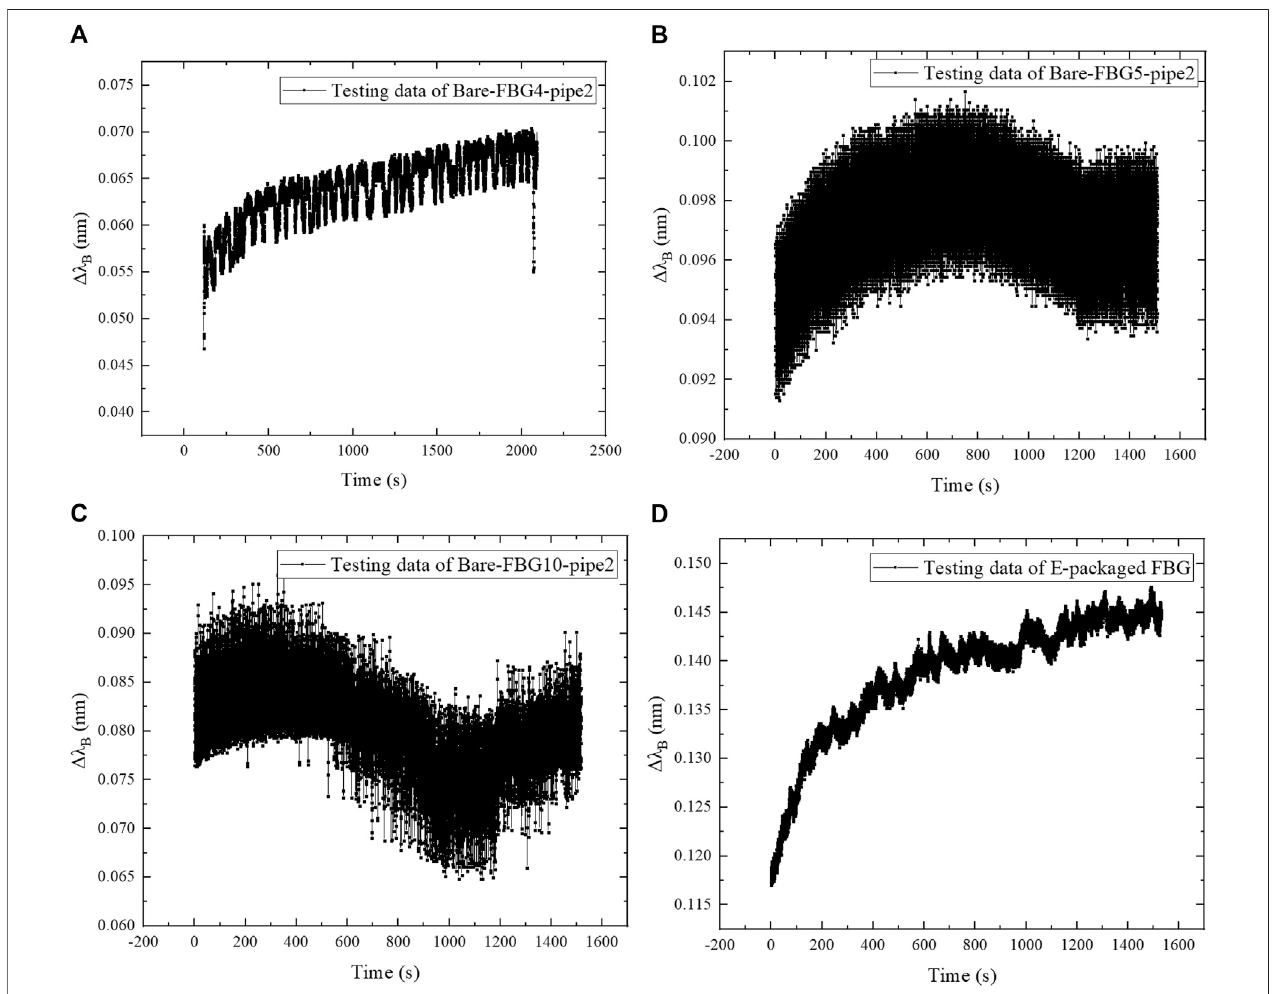
FIGURE 6 | Relationship of central wavelength increment with loading time at 10 Hz: (A) Bare-FBG4-pipe2; (B) Bare-FBG5-pipe2; (C) Bare-FBG10-pipe2; (D) E-packaged FBG.